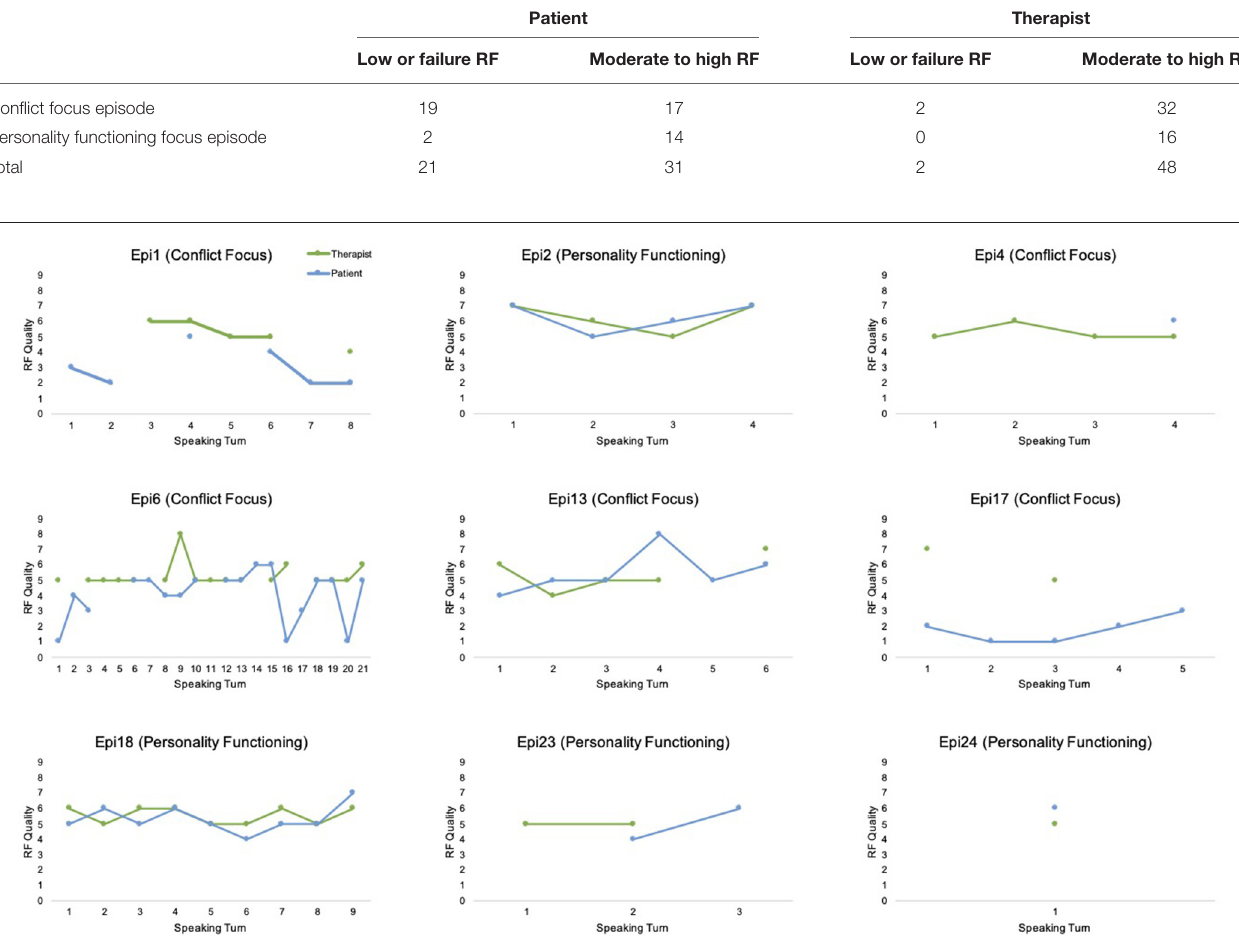
FIGURE 2 | Quality of mentalization of therapist and patient in each